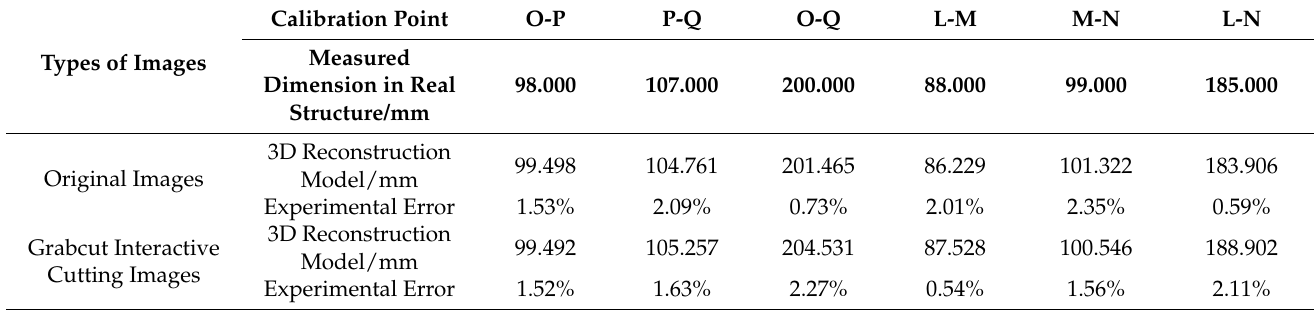
Table 3. Comparison of the size for actual structure and reconstruction